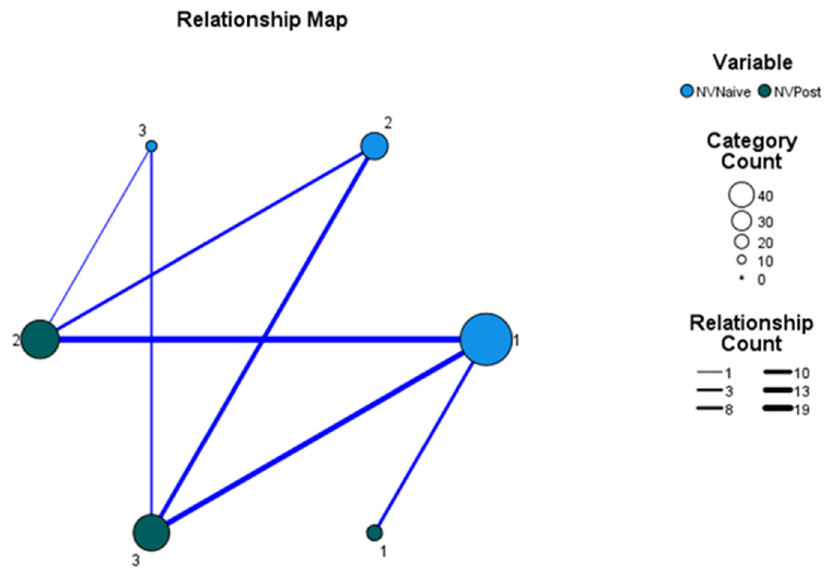
Figure 5. Relationship map—between the naïve type of NV membrane and the type after therapy— group “differentiated”. The thickness of the line is directly proportional to the strength of the connection. Legend: NV naïve—“naïve” form of a neovascular membrane, before therapy; NV post—A form of the nonvascular membrane after three. intravitreal anti-VEGF applications with a month interval between them. 1—Sea fan; 2—Medusa; 3—Dead tree.